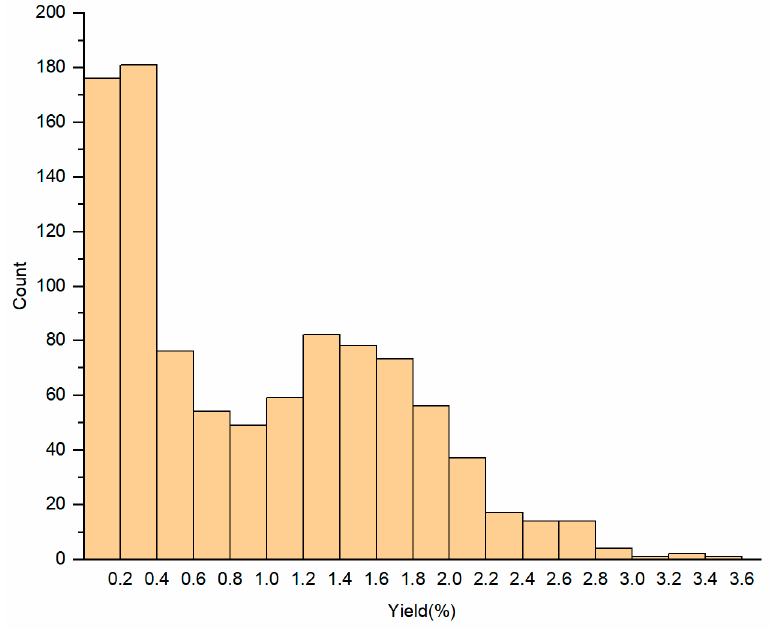
Figure 1. Frequency distribution of the essential oil yield of C. camphora . There was a significant difference among the essential oil yields of the different populations ( p < 0.01). Camphor trees from Qimen had the highest mean essential oil yield (2.01%), followed by those from the Xinhua, Hanzhong, and Enshi populations, with mean oil yields of 1.70%, 1.54%, and 1.51%, respectively (Table 1). These four pop- ulations had high oil yields (>1.50%). Two populations from Guangdong (GD-SG and GD-ZJ), two from Fujian (FJ-FZ and FJ-HA), one from Jiangsu (JS-ZJ), one from Sichuan (SC-LX), and one from Zhejiang (ZJ-YY) exhibited low essential oil yields. Pearson’s correlation coefficient analysis revealed that essential oil yield was positively correlated with latitude. In other words, trees growing at high latitudes had higher oil yields than those growing at low latitudes. In contrast, essential oil yield was negatively correlated with longitude; higher oil yields were detected in camphor trees in western China (Table 2). Table 1. Geographical information of samples of C. camphora populations with mean essential oil yield of each population.